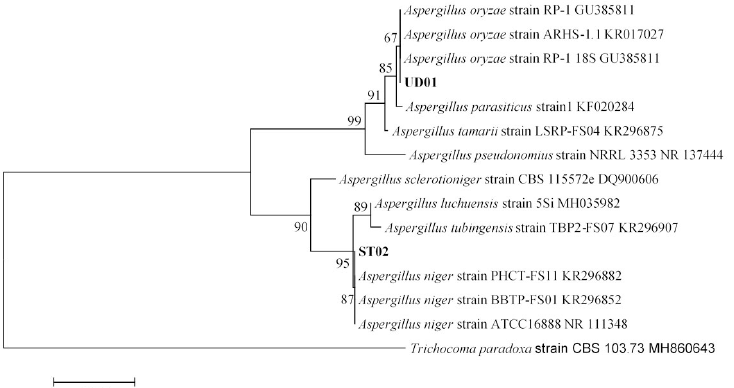
Fig. 6.(C). A phylogenetic tree of Aspergillus oryzae (UD01) and Aspergillus niger (ST02) constructed with the dataset based on ITS gene sequences. The tree was generated from Neighbor Joining Analysis (NJ), and NJ Boostrap (NJBS) values were calculated and shown on the